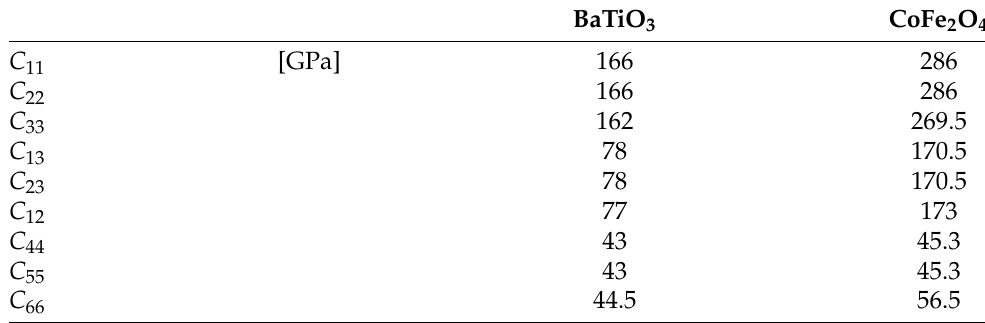
Table 1. Piezo-electro-magnetic-thermal properties of materials BaTiO 3 and CoFe 2 O 4